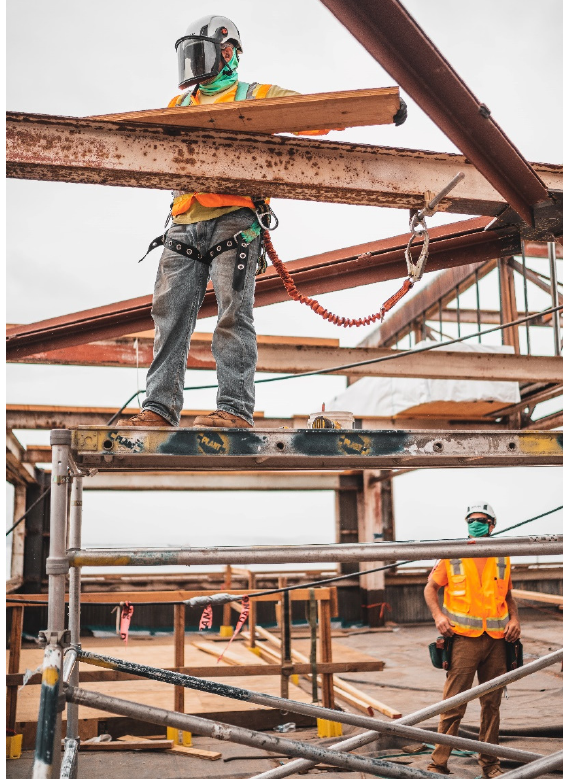
Figure 10. Use of tie-off while working at heights (adapted and used with permission from Villegas [39]). Appropriate safety measures must be taken to avoid cement burn. Construction professionals must wear rubber boots while pouring and compacting concrete to protect gloves, rain pants, safety glasses, washing of the skin, and use of certain moisturizers should be adopted for concrete jobs. In terms of safety, the other major things that need to be considered are adequate access and egress and compliance with the engineering drawings. The protruded rebar ends should also be covered with safety caps (see Figure 12). Moreover, the safety requirements should not be just based around the workers and the surrounding environment, it is also very important to ensure that the equipment are in safe working order [40]. Lifting heavy loads (e.g., formwork, falsework, concrete bucket) safely requires that the crane has adequate lifting capacity, and the rigging points are flawless. Therefore, the crane and rigging points must be inspected to ensure compliance with safety standards before lifting heavy loads.